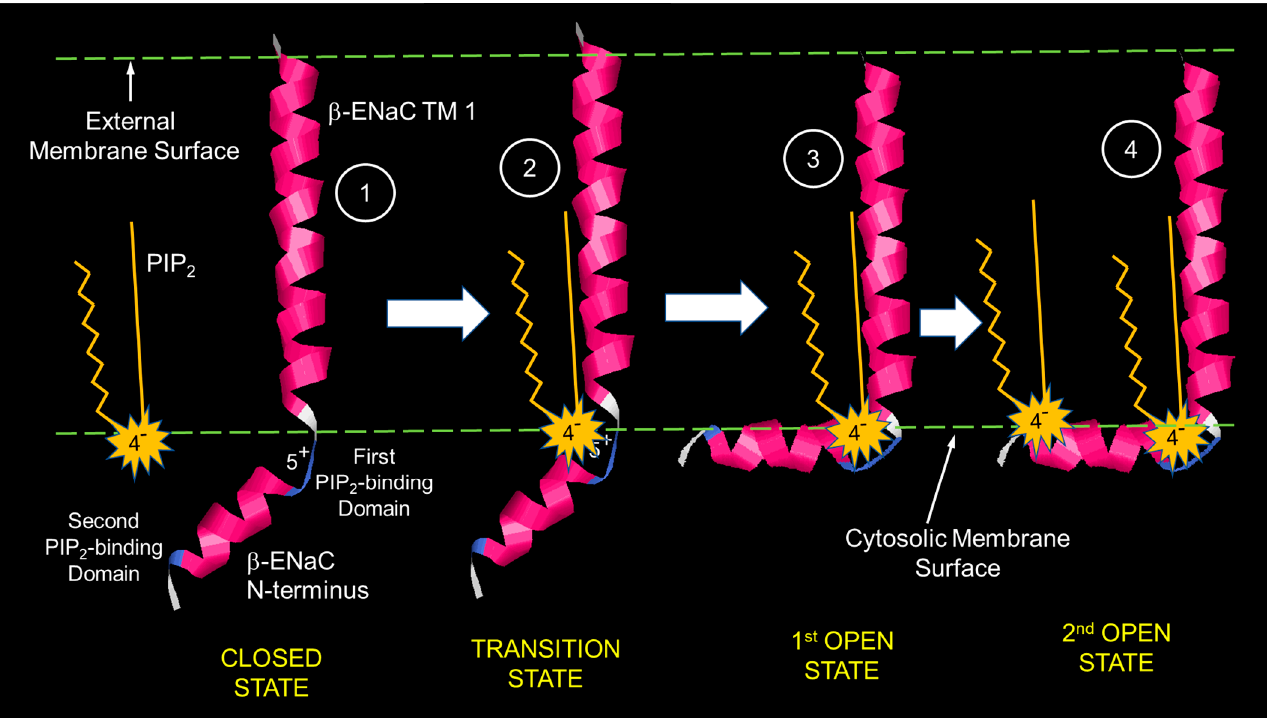
Figure 11. Schematic of PIP 2 activation of ENaC. In 1, PIP2 and the N-terminus of b-ENaC are separated, and the cytosolic domain of b-ENaC is free; in 2, PIP 2 is attracted to the positive charge of b-ENaC’s PIP 2 binding domain; in 3, b-ENaC’s N-terminus folds to be in close association with PIP 2 ′ s head group and the inner surface of the membrane. The change in conformation also gates ENaC open transiently. In 4, the second PIP 2 binding domain associates with a second PIP 2, which stabilizes ENaC, leading to the second open state. The channel may make many transitions back and forth between the two open states.